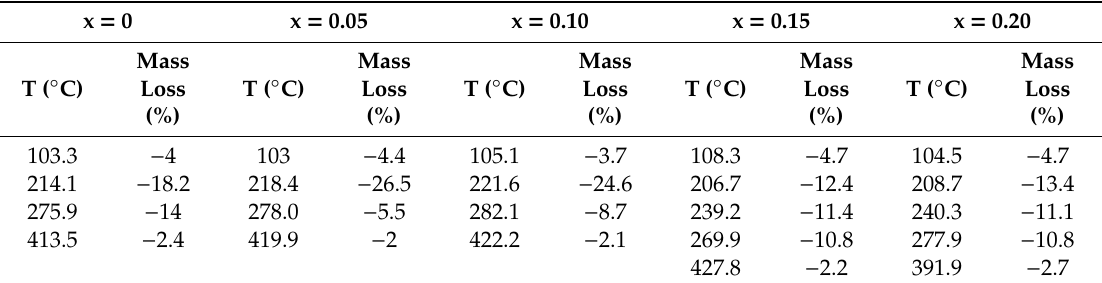
Table 2. TG-DSC e ff ects corresponding to Bi 1 − x Eu x FeO 3